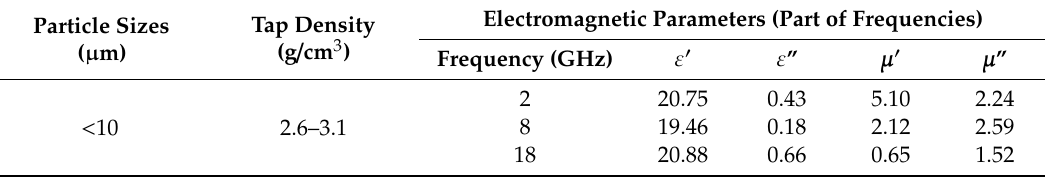
Table 1. Basic properties and electromagnetic parameters of BD-MZ-1 carbonyl iron powders (CIPs). Particle